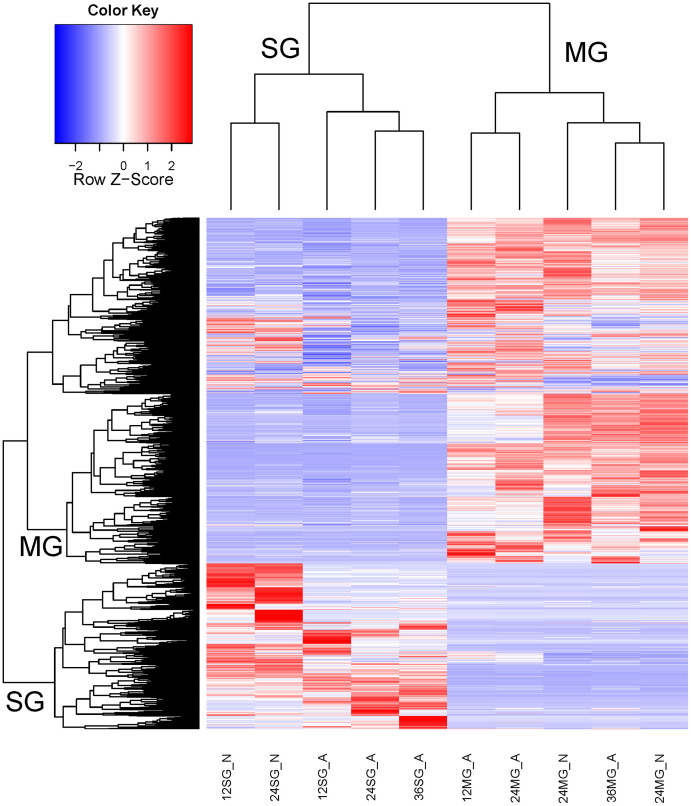
Heat map of normalized RPKM data from the salivary glands (SG) and midguts (MG) of nymphal and adult Ixodes ricinus fed for different periods of time.The Z score represents the deviation from the mean by standard deviation units. For other details, please see the Figure 2 legend.